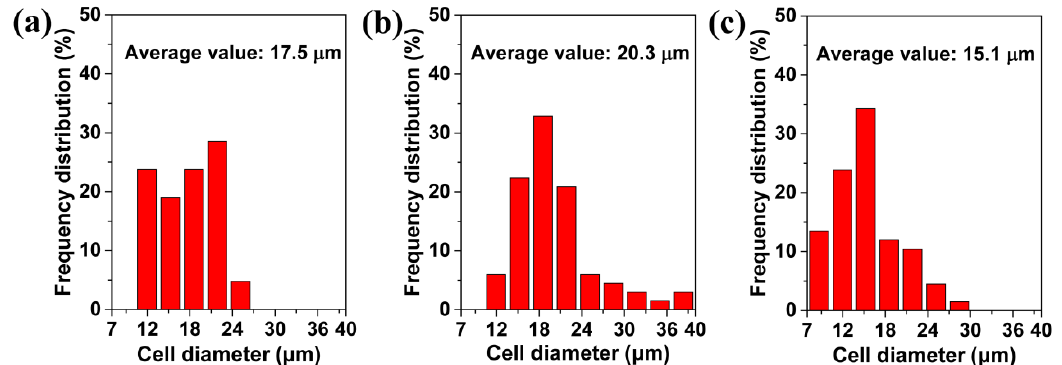
Figure 6. The average value of cells on the surface of TPU perforated membrane saturated under 1.5 MPa and foamed at di ff erent temperatures of: ( a ) 120 ◦ C, ( b ) 130 ◦ C, and ( c ) 140 ◦ C.